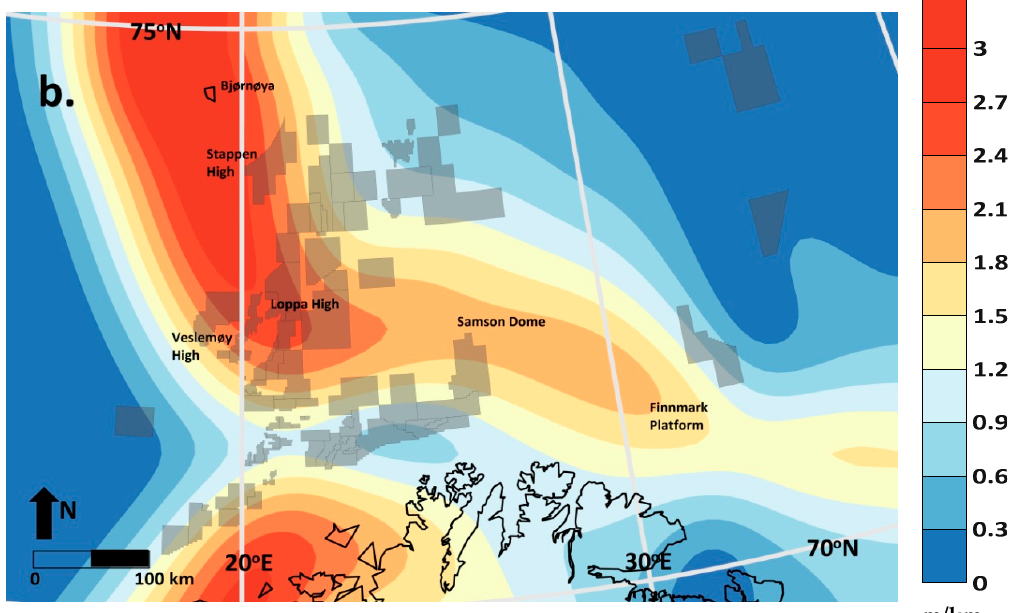
Figure 2. Calculated tilts (m/km) due to glacial isostasy for the LGM ice sheet (based on [3] ). The white box in a ) marks the Norwegian part of the Barents Sea that is open for petroleum exploration (production licenses are marked in grey). The tilts of this area are shown in b ).